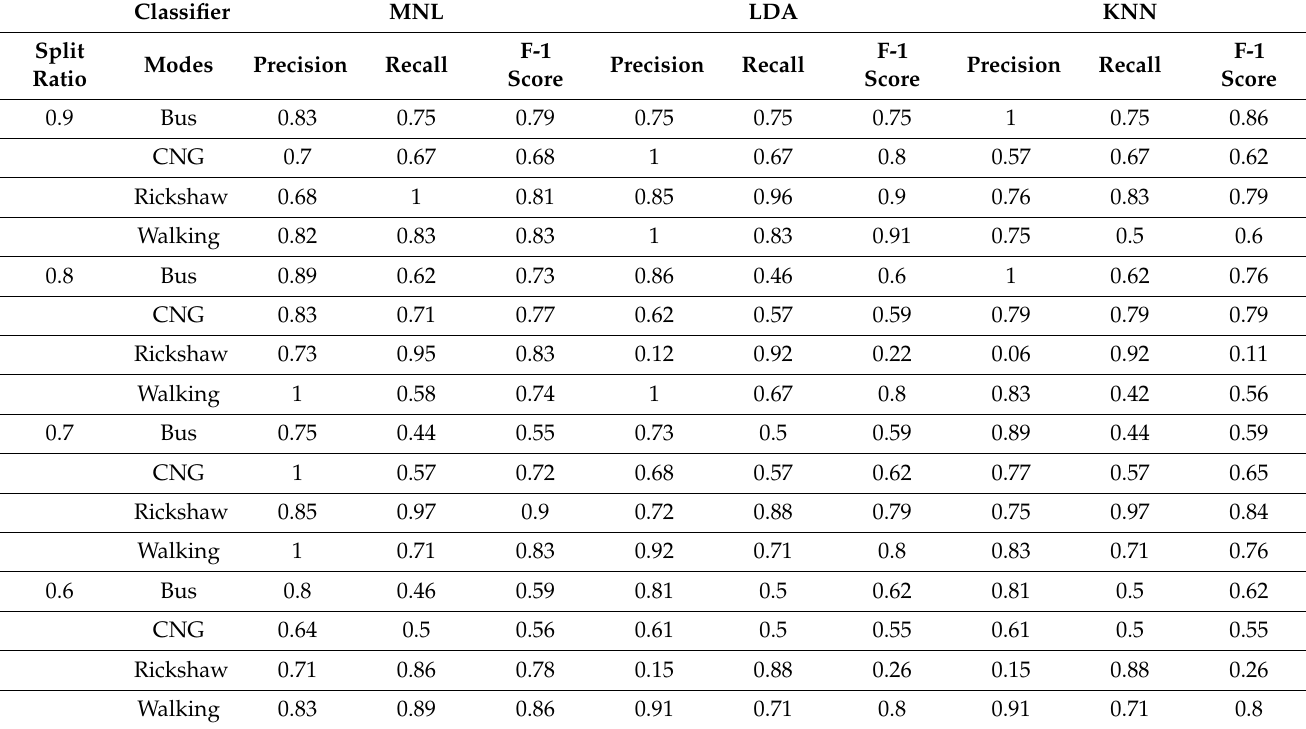
Table 4. Precision, Recall, and F1-Score for MNL, LDA, and KNN.